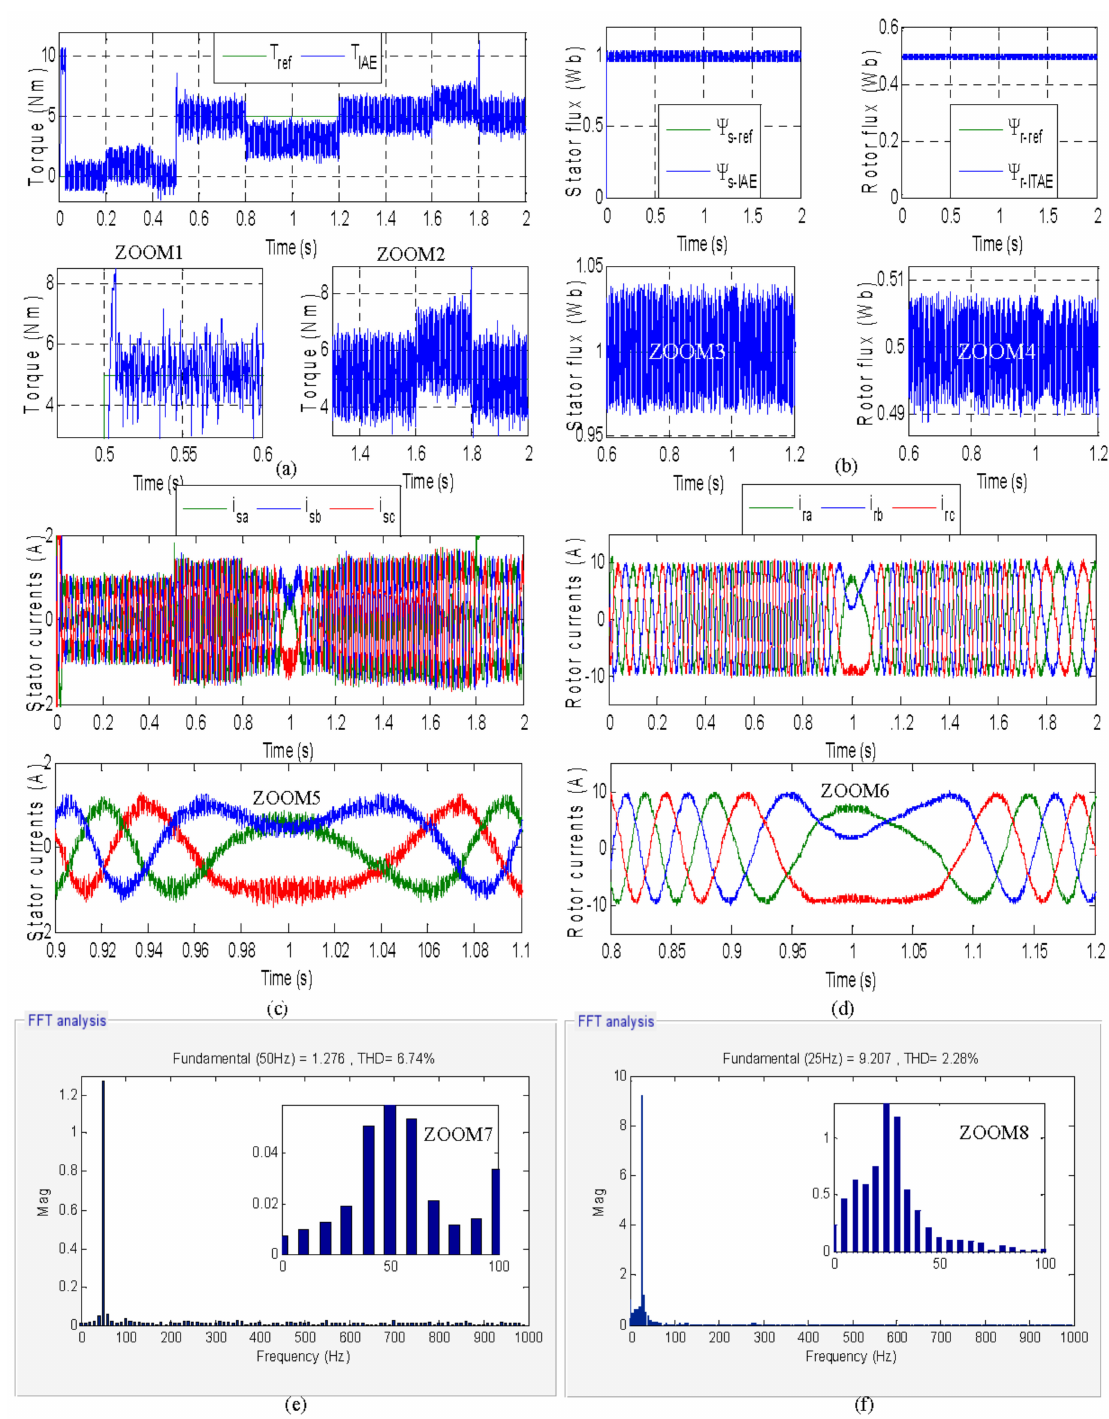
Figure 8. GA-DTC-IAE performances. ( a ) The electromagnetic torque response. ( b ) The fluxes response. ( c , d ) The stator and rotor currents. ( e , f ) Harmonic spectra of the stator and rotor